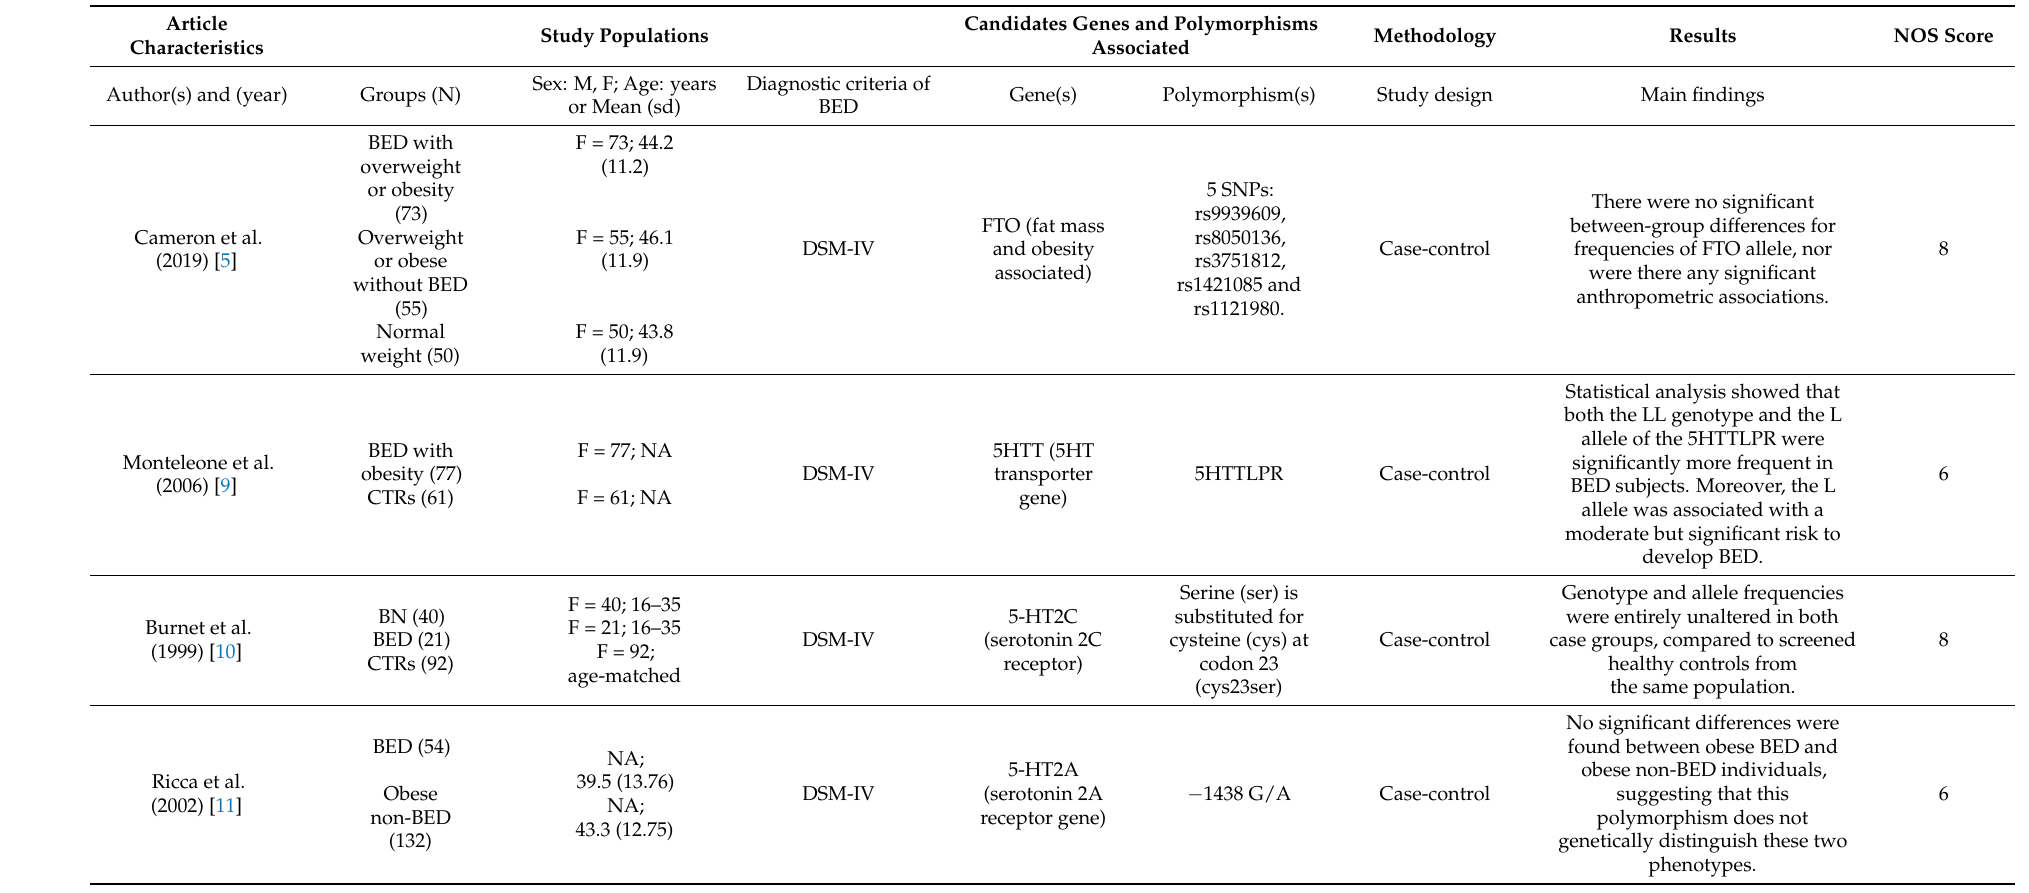
Table 1. Characteristics of the included